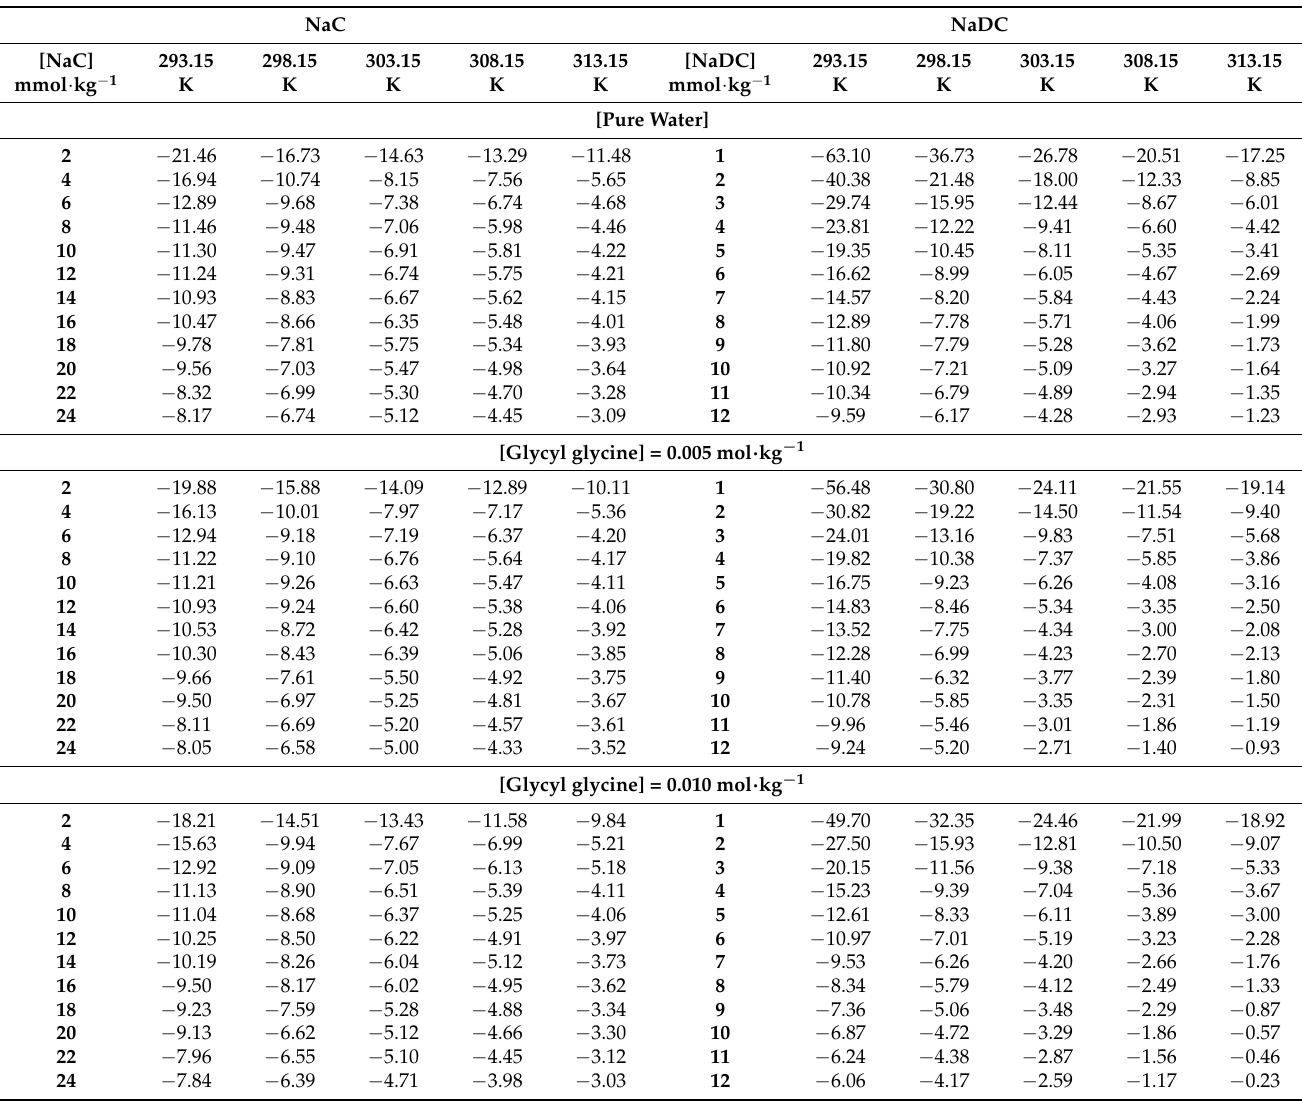
Table 3. Apparent molar isentropic compression, κ s , φ /10 − 3 (m 3 · mol − 1 · Pa − 1 ) values for NaC